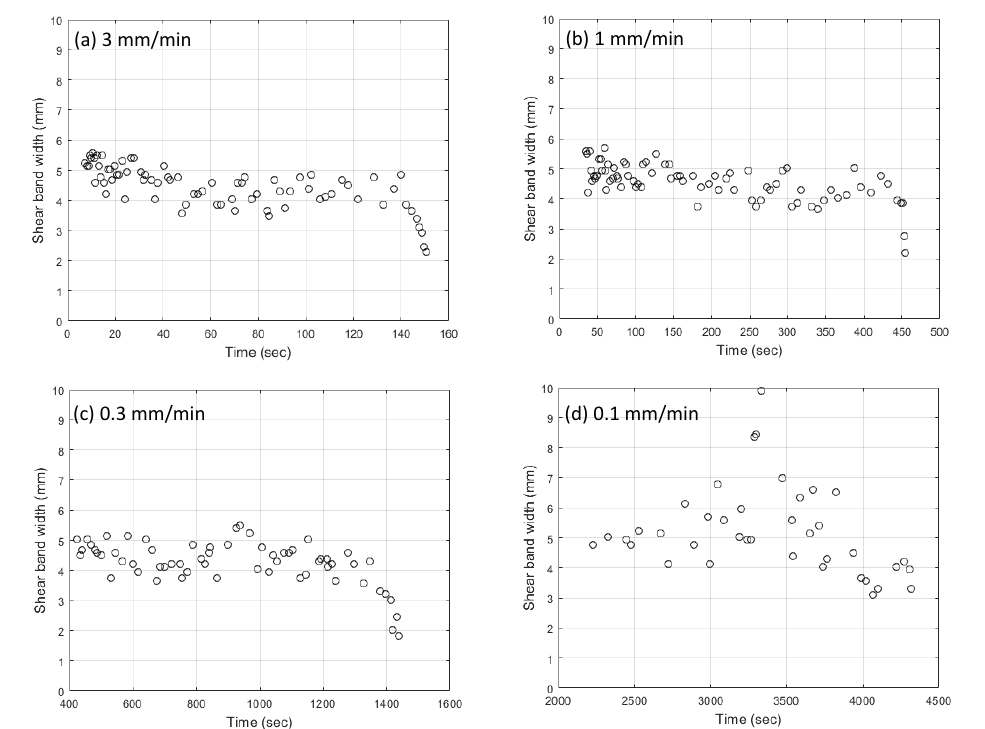
Figure 10. Temporal change in shear band width. Pulling rate is ( a ) 3.0 mm/min, ( b ) 1.0 mm/min, ( c ) 0.3 mm/min and ( d ) 0.1